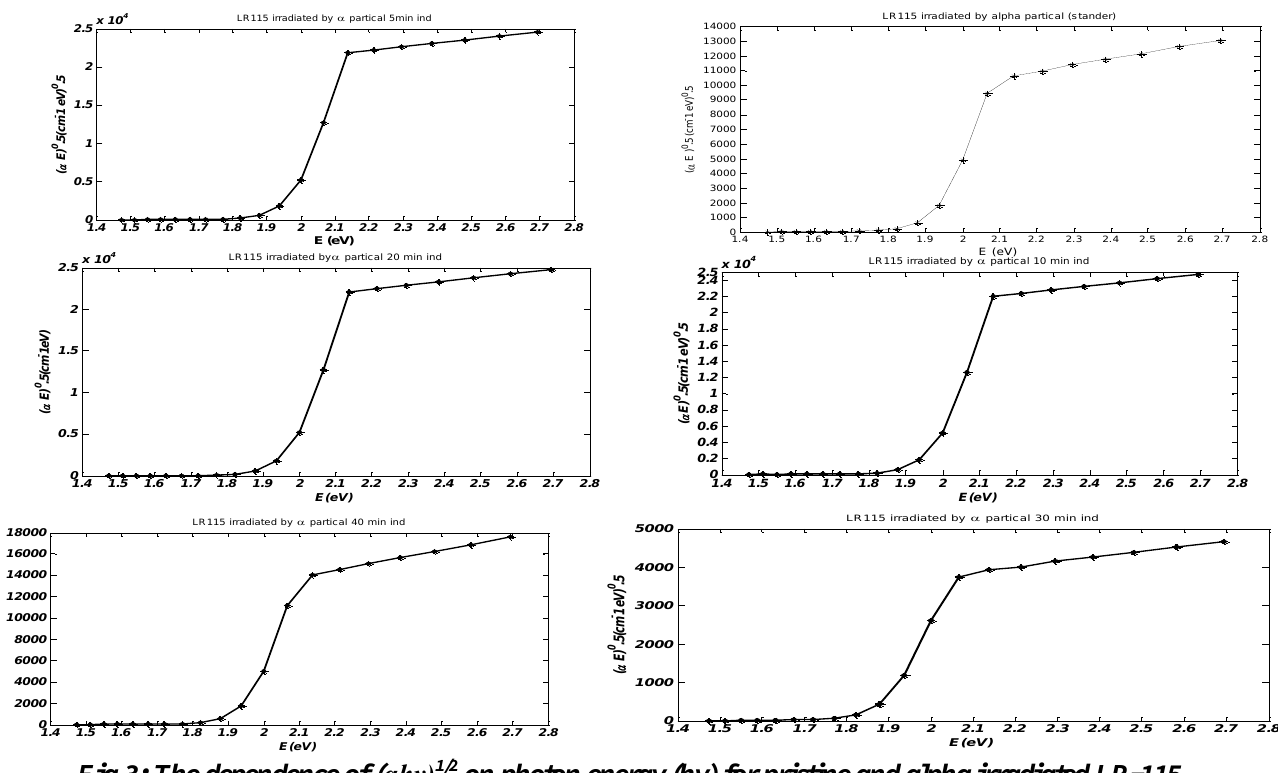
Fig.3: The dependence of (αhv) 1/2 on photon energy (hv) for pristine and alpha irradiated LR-115